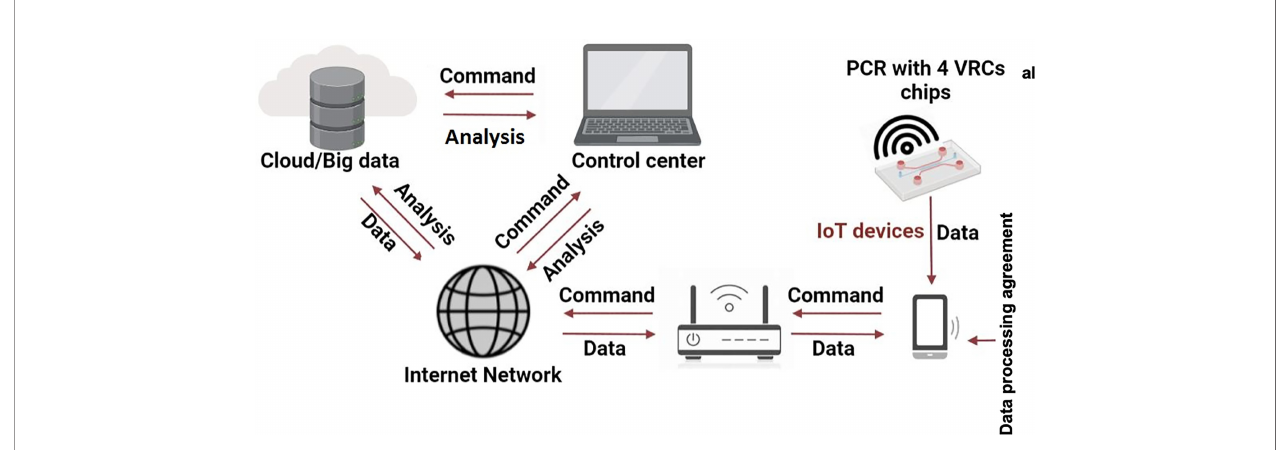
FIGURE 2 | Working principle of an IoT PCR for RTI detection and spread monitoring. Adapted with permission from (Zhu et al.,